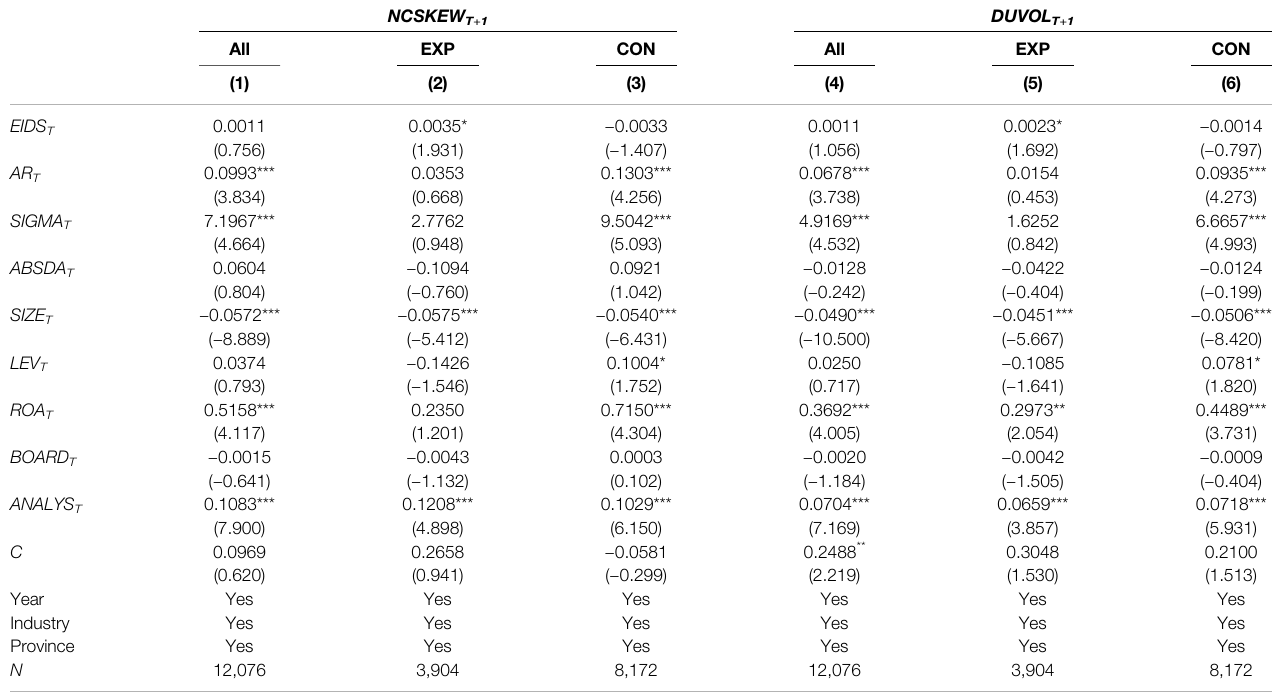
TABLE 6 | Robustness test of substitution